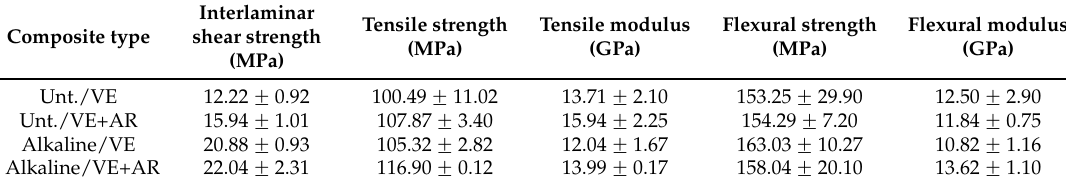
Table 4. Normalized results of mechanical tests for untreated and treated flax fiber with VE and VE+AR resins.